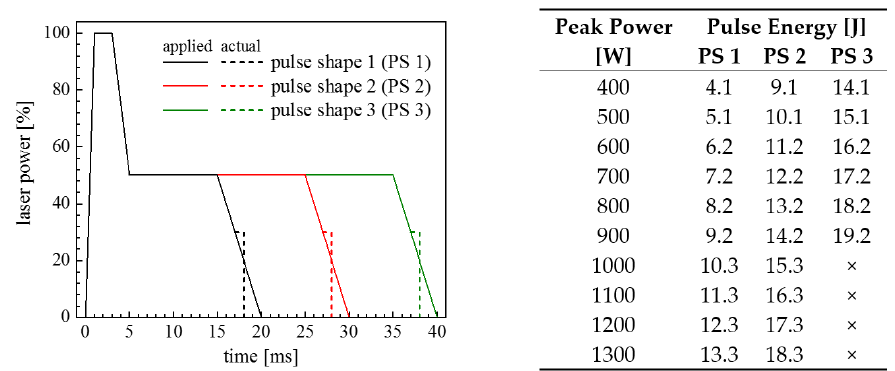
Figure 3. Schematic representation of the applied and actual pulse shapes ( left ) and summary of the applied laser peak powers and corresponding pulse energies for the different actual pulse shapes ( right ).